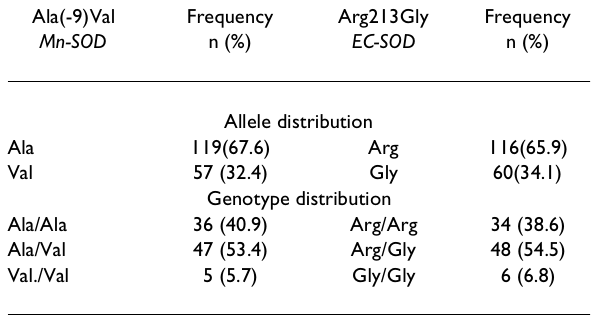
Table 2: Allele and genotype distribution of the Ala(-9)Val Mn- SOD and Arg213Gly EC-SOD polymorphic markers in healthy